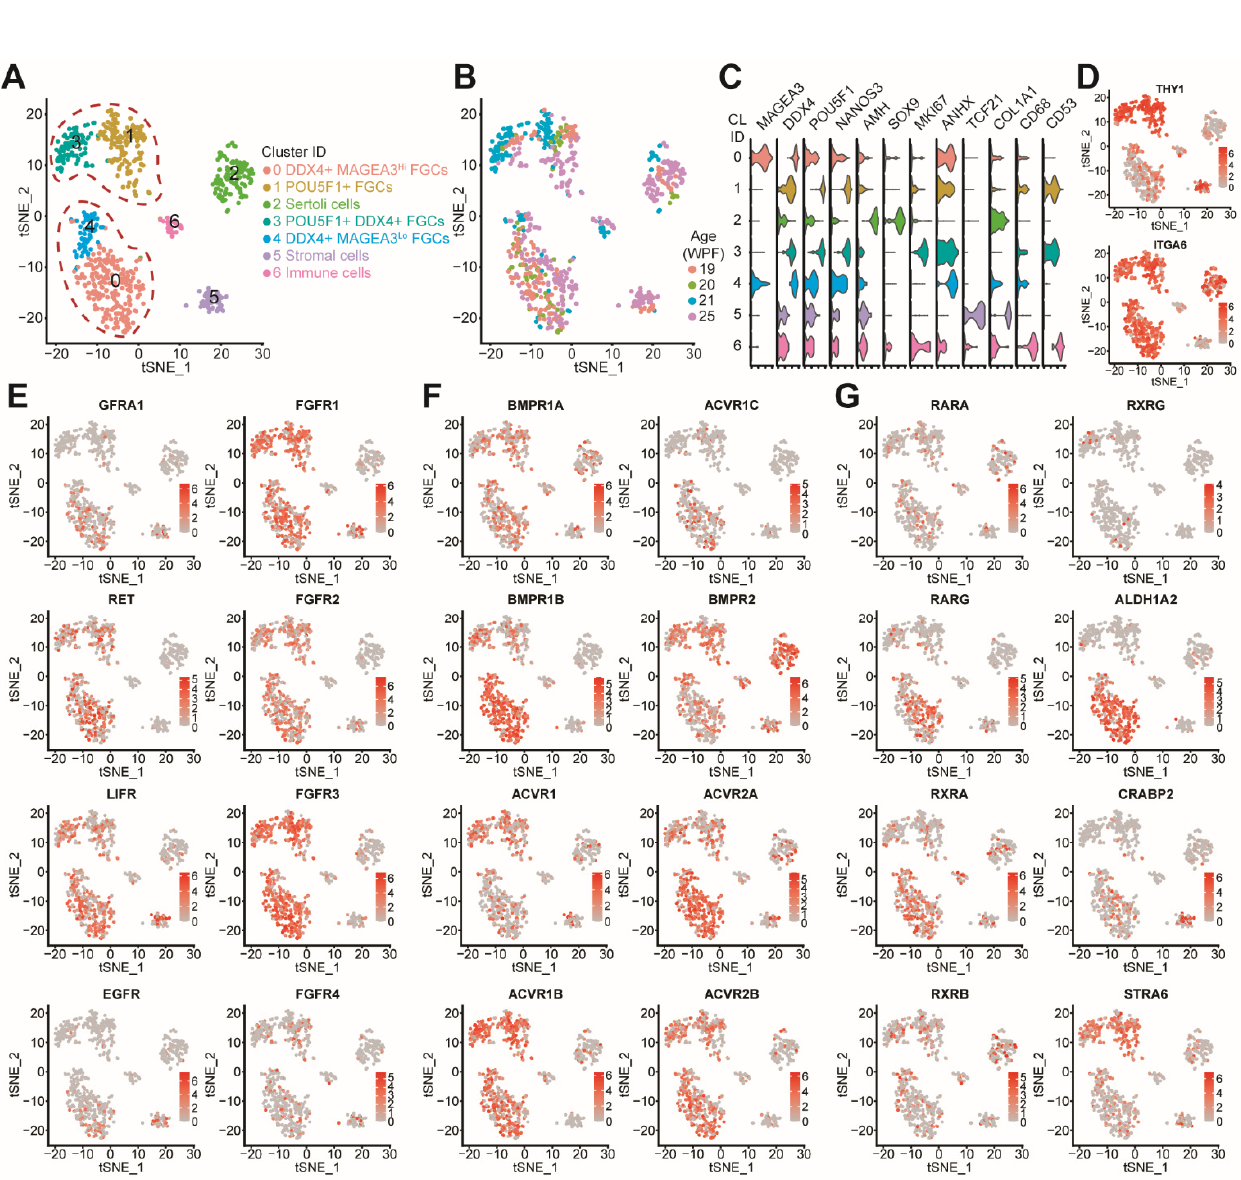
Figure 5. Gene expression analysis of single cell RNASeq data of male fetal gonads. ( A ) tSNE plot of single cell data from Li et al. (2017) ( n = 5 different donors). A total of 7 clusters (cluster 0–6) were identified. ( B ) t-SNE plot colored by age in weeks post fertilization (WPF). ( C ) Violin plots showing expression of representative genes for each cluster. ( D ) tSNE feature plots showing the expression of THY1 and ITGA6. ( E ) tSNE feature plots showing the expression of specific receptors associated with signaling pathways activated by the Shinohara-medium. ( F ) tSNE feature plots showing the expression of specific receptors associated with the BMP-ActA signaling pathway activated by the adapted Zhou-medium. ( G ) tSNE feature plots showing the expression of specific receptors associated with the RA signaling pathway activated by the adapted Zhou-medium.